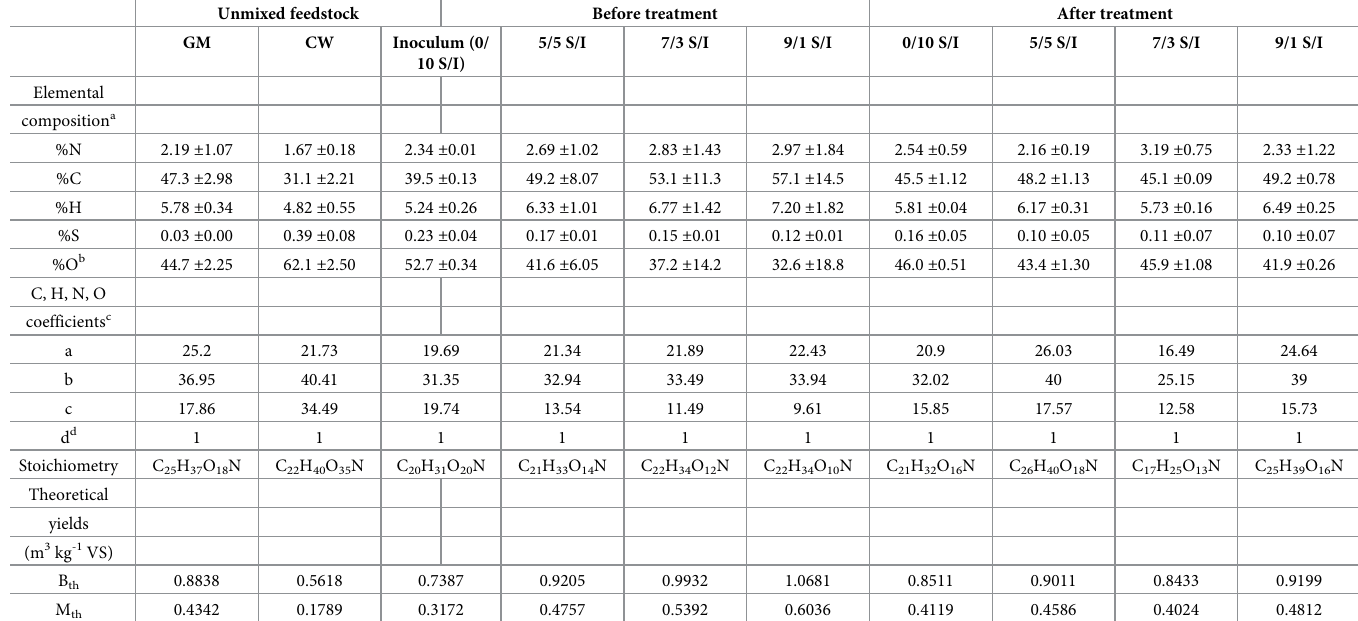
Table 3. Elemental characteristics (CHNOS) of the substrates and digestate at varying substrate-to-inoculum (S/I) ratio through the course of treatment. Unmixed feedstock Before treatment After